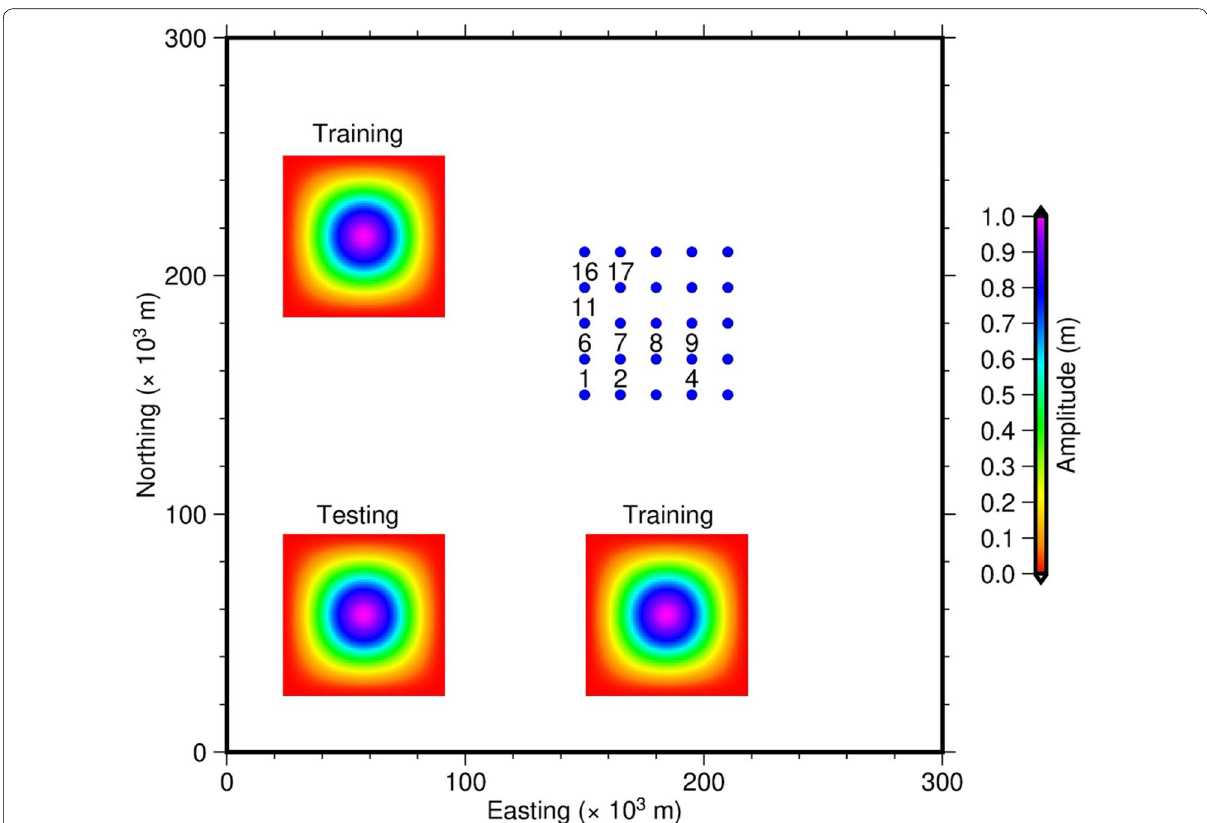
Fig. 3 Domain of the simple bathymetry case. The colored area indicates the location of the cosine basis function of the initial water surface for training and testing purposes. The blue dots indicate the array of the observational